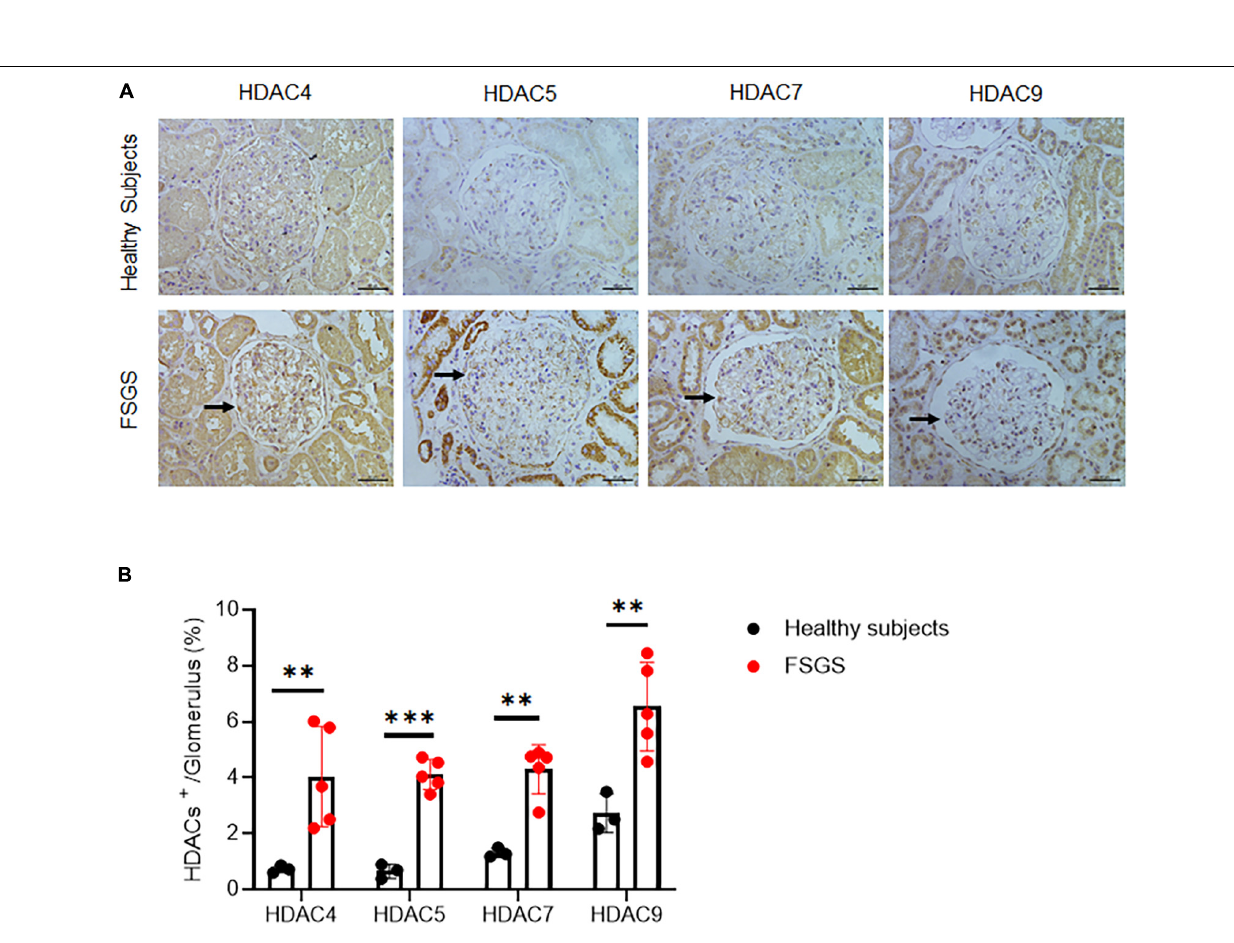
FIGURE 2 | Validation of HDAC IIa in patients with FSGS. (A) IHC staining of HDAC IIa members (arrows indicate the positive stainings) in normal ( n = 3) and FSGS ( n = 5) kidney tissues. Scale bar, 40 µ m. (B) Quantitative analysis of HDAC IIa IHC staining. Statistical analysis was performed with two-tailed, unpaired t -test. ∗∗ p < 0.01; ∗∗∗ p <